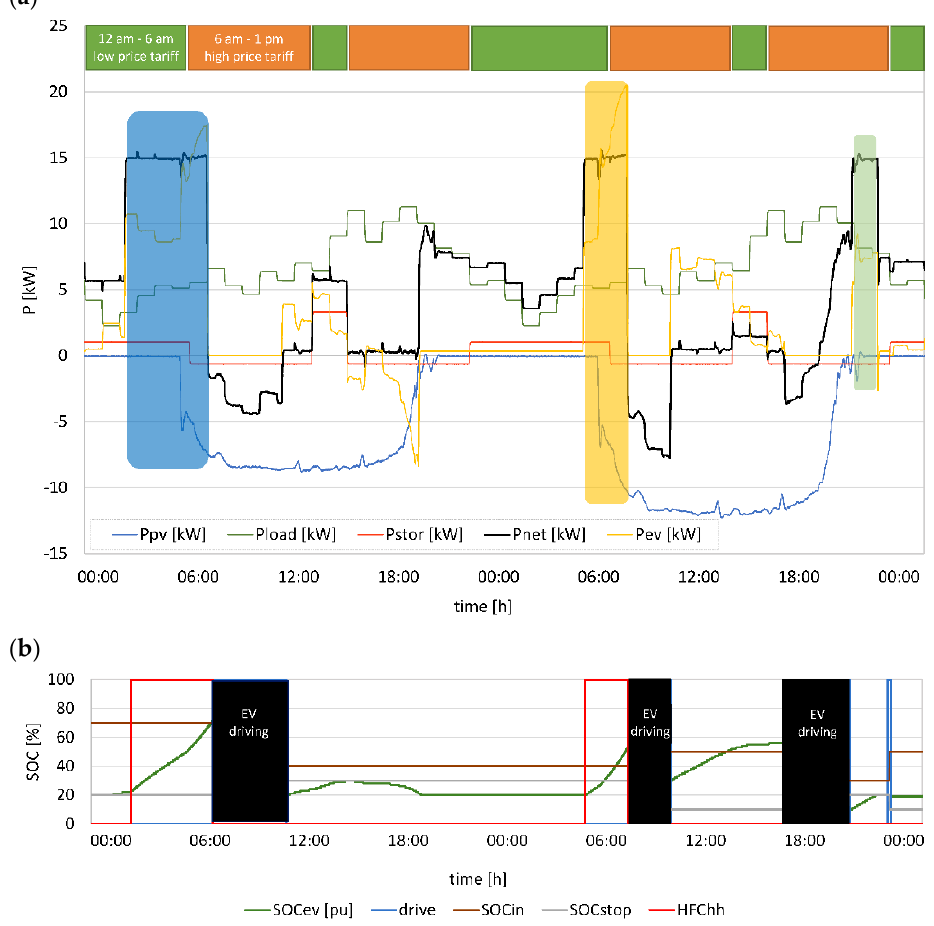
Figure 6. Scenario 3. Home installation operation with time-dependent storage.